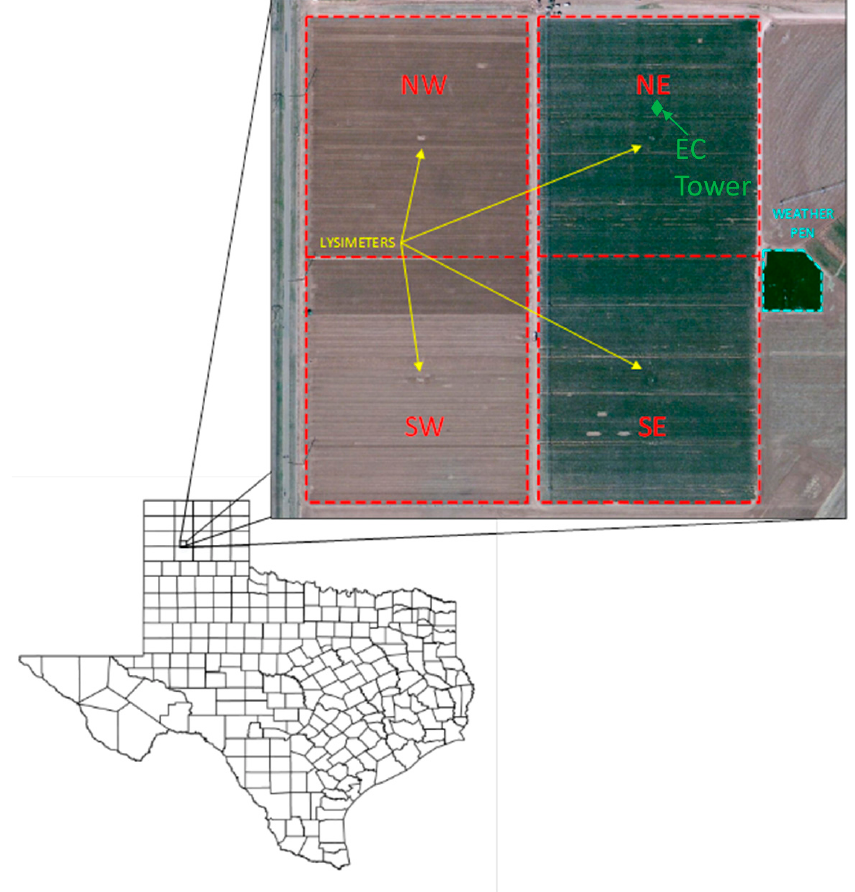
Figure 2. Study location and layout of the lysimeters (yellow arrows) in the northeast (NE), southeast (SE), northwest (NW), and southwest (SW) quadrants with the location of the eddy covariance system in the NE quadrant.